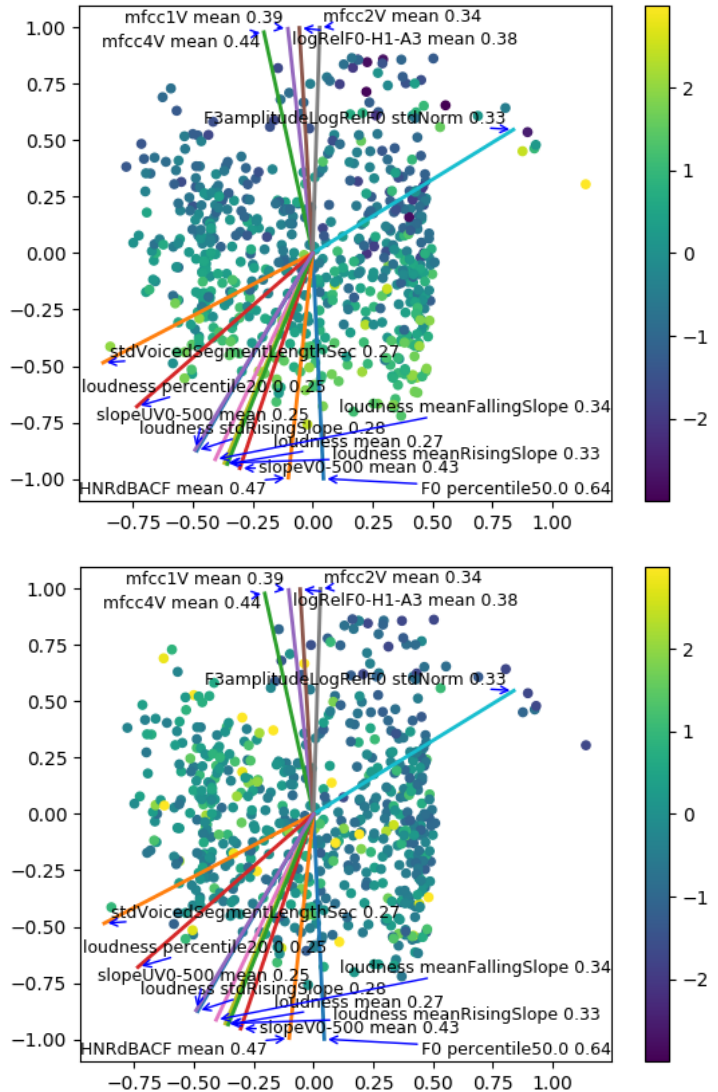
Figure 4. Reduced latent space with directions of gradients of features. The color of each point is the value of F0 median ( top ) and voiced segment lengths standard deviation ( bottom